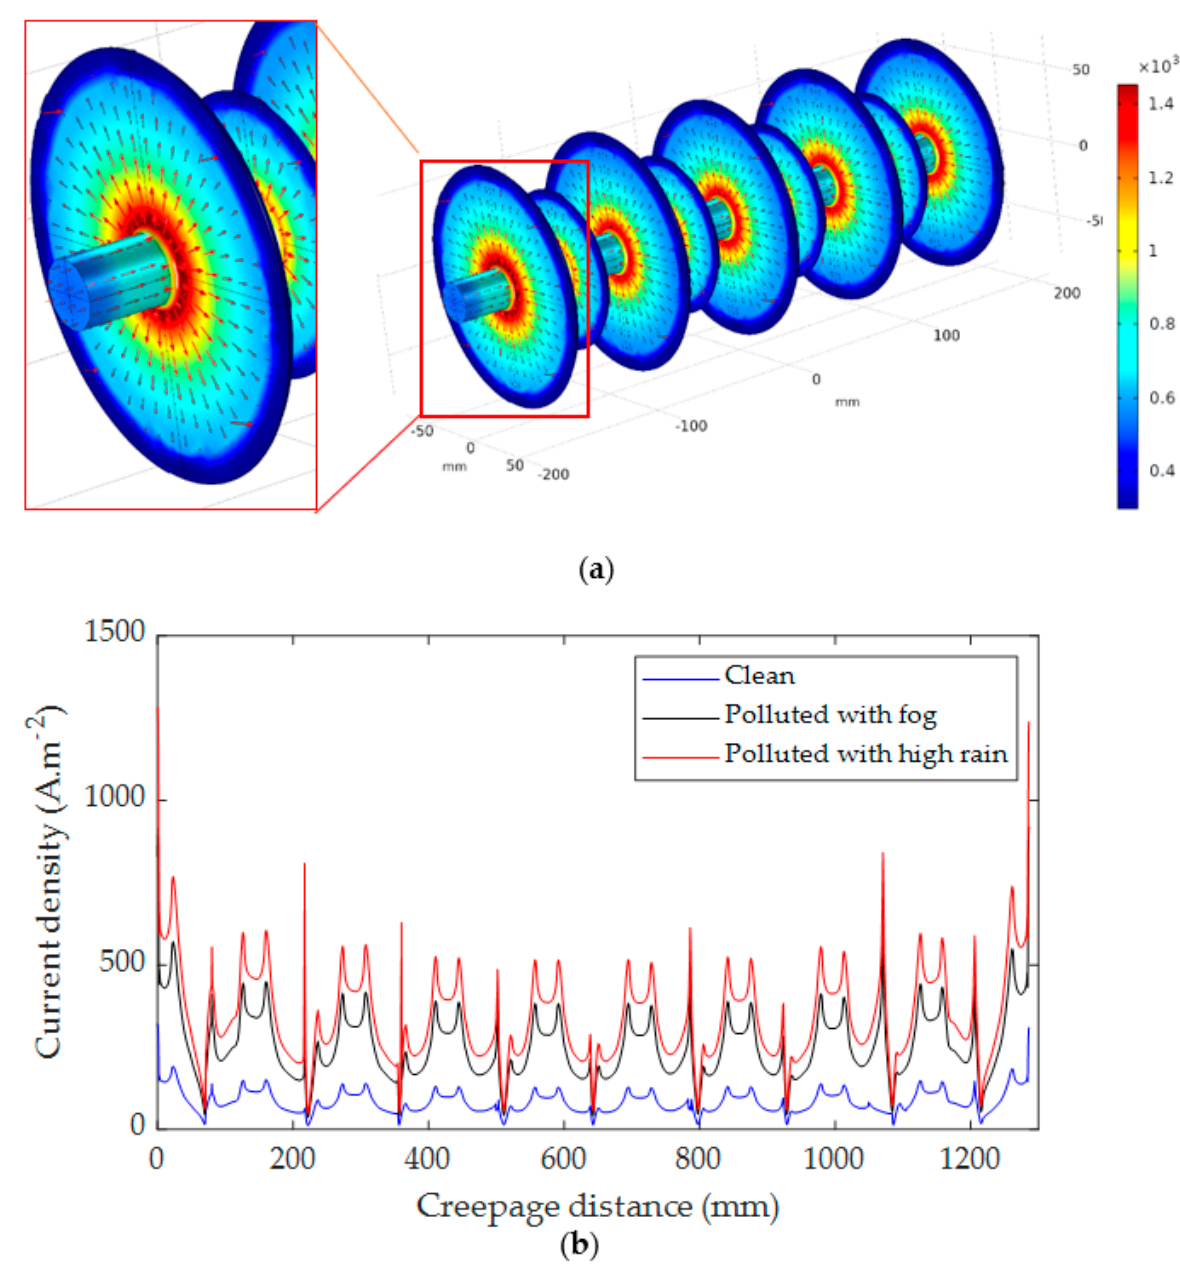
Figure 19. Current density distribution for insulator type II: ( a ) 3-D simulation view; ( b ) Current density distribution along the insulator.